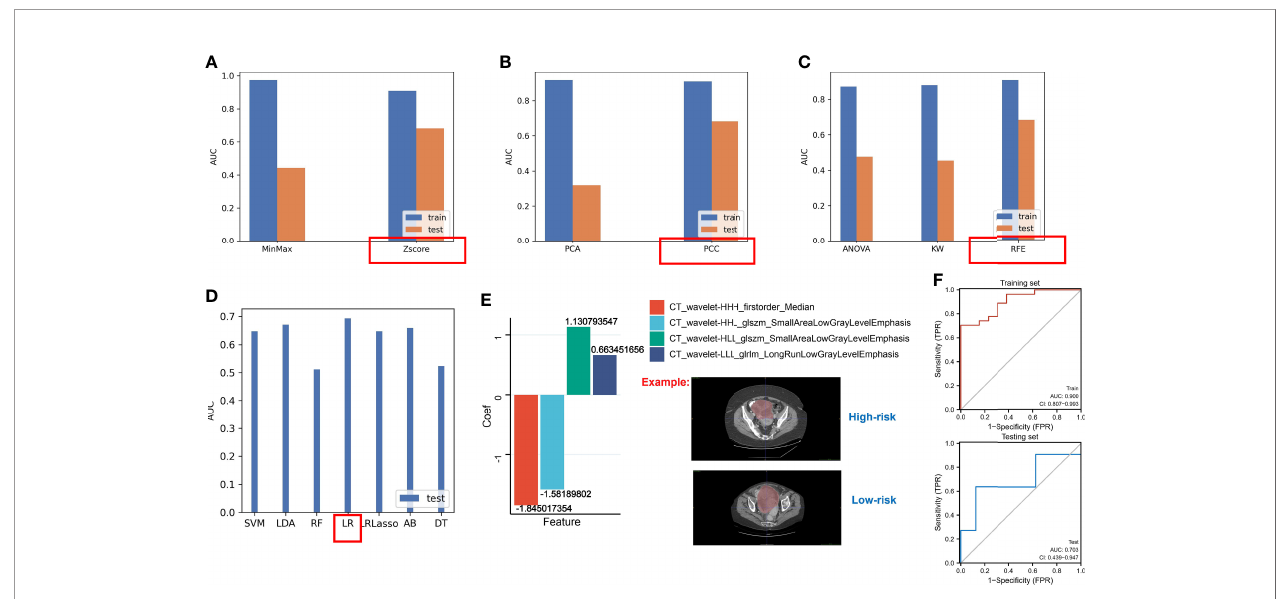
FIGURE 10 | The AUC values of different methods. (A) The AUC values of methods for normalization. (B) The AUC values of methods for feature preprocessing. (C) The AUC values of methods for dimensionality reduction. (D) The AUC values of methods for generating the fi nal signature. (E) LR regression coef fi cients and features. (F) The AUC values of the testing set and the training set based on the optimal radiomics